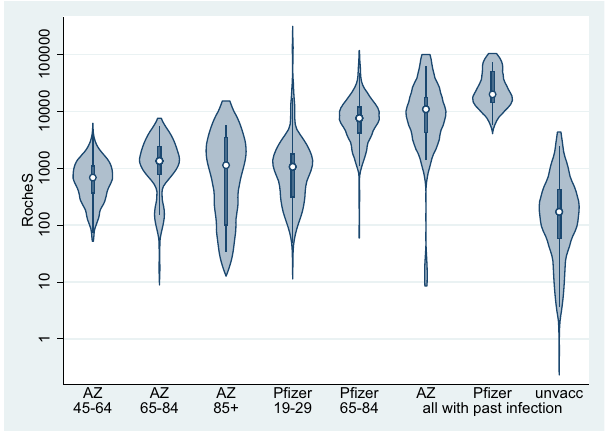
Fig. 3 Violin plots, antibody responses at 14 – 34 days following the second dose of COVID-19 vaccine in (i) previously uninfected individuals, by vaccine and interval between doses, (ii) in previously infected individuals by the vaccine (any schedule) and (iii) in unvaccinated convalescent individuals. S-antibody response 14 – 34 days after dose 2 . N = 471 CONSENSUS participants tested 14 – 34 days after dose 2 and 87 convalescent sera in unvaccinated cases. The violin plots show the RocheS results of our CONSENSUS cohort. The centre represents the median, the thick central line the interquartile range, the thin central line the range (minus outliers) and the violin outline a smoothed kernel density estimation.